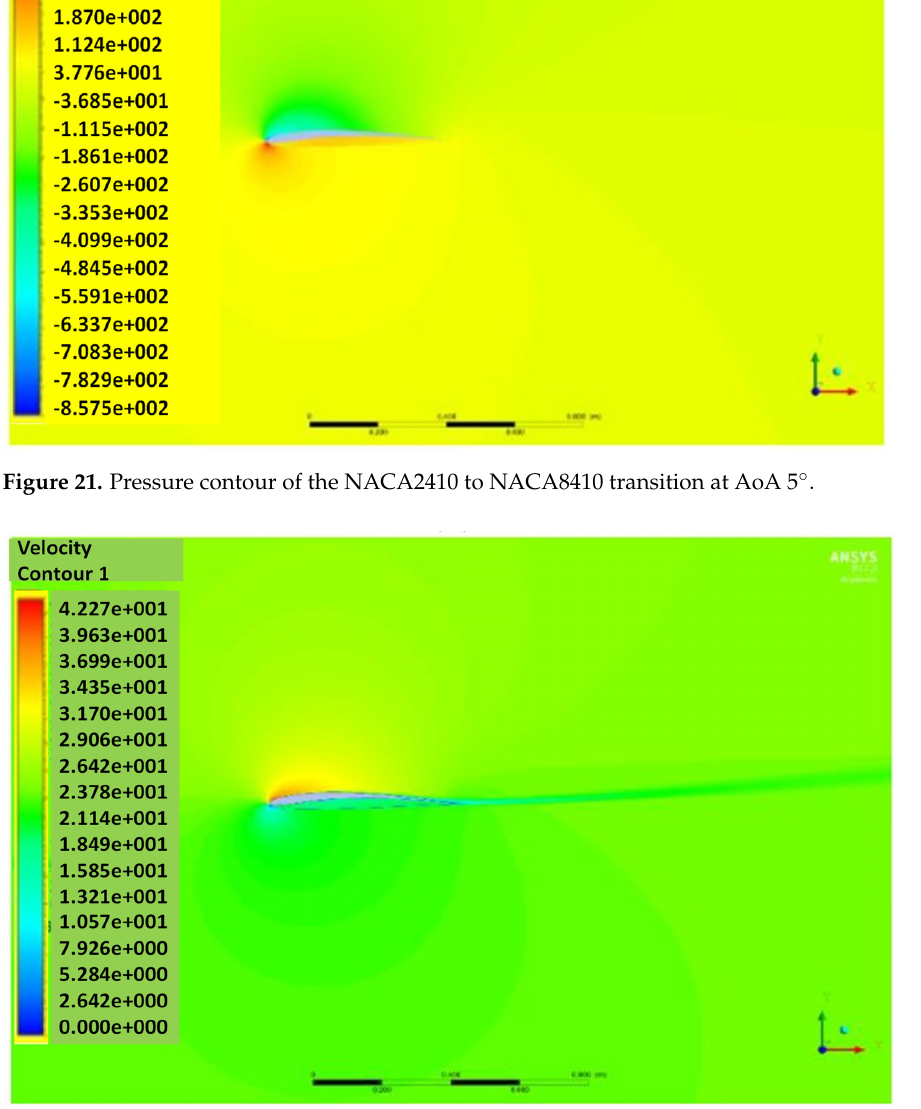
Figure 22. Velocity contour of NACA2410 to NACA8410 transition at AoA 5°. Figure 23 shows the contour of the turbulent kinetic energy at 5° AoA. It is noted that the turbulent energy is highly dense near the trailing edge and downstream.